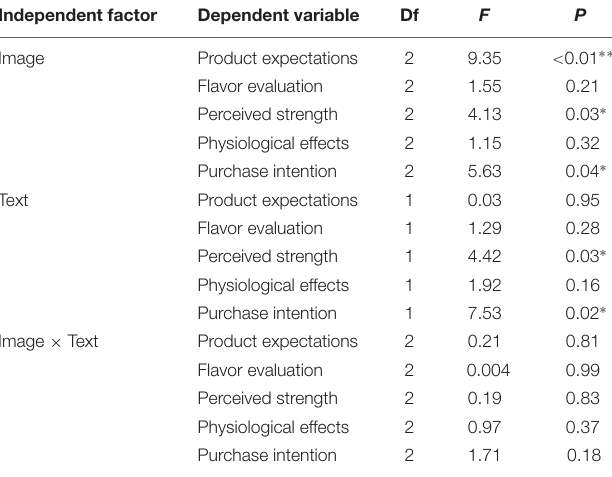
TABLE 3 | Main MANOVA